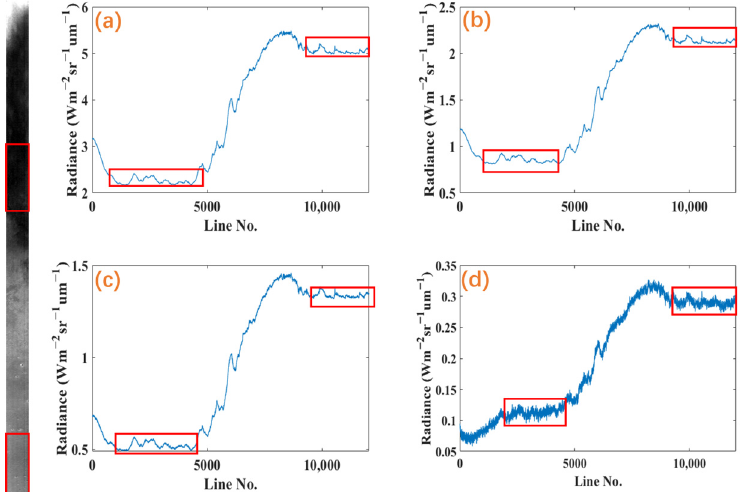
Figure 3. A complete push ‐ broom detection example (left). Radiance trends of different bands. The center wavelengths are ( a ) 1656.5 nm, ( b ) 2140.8 nm, ( c ) 2433.7 nm, and ( d ) 3307.2 nm. The red boxes show that there are bright and dark regions in various bands (right).